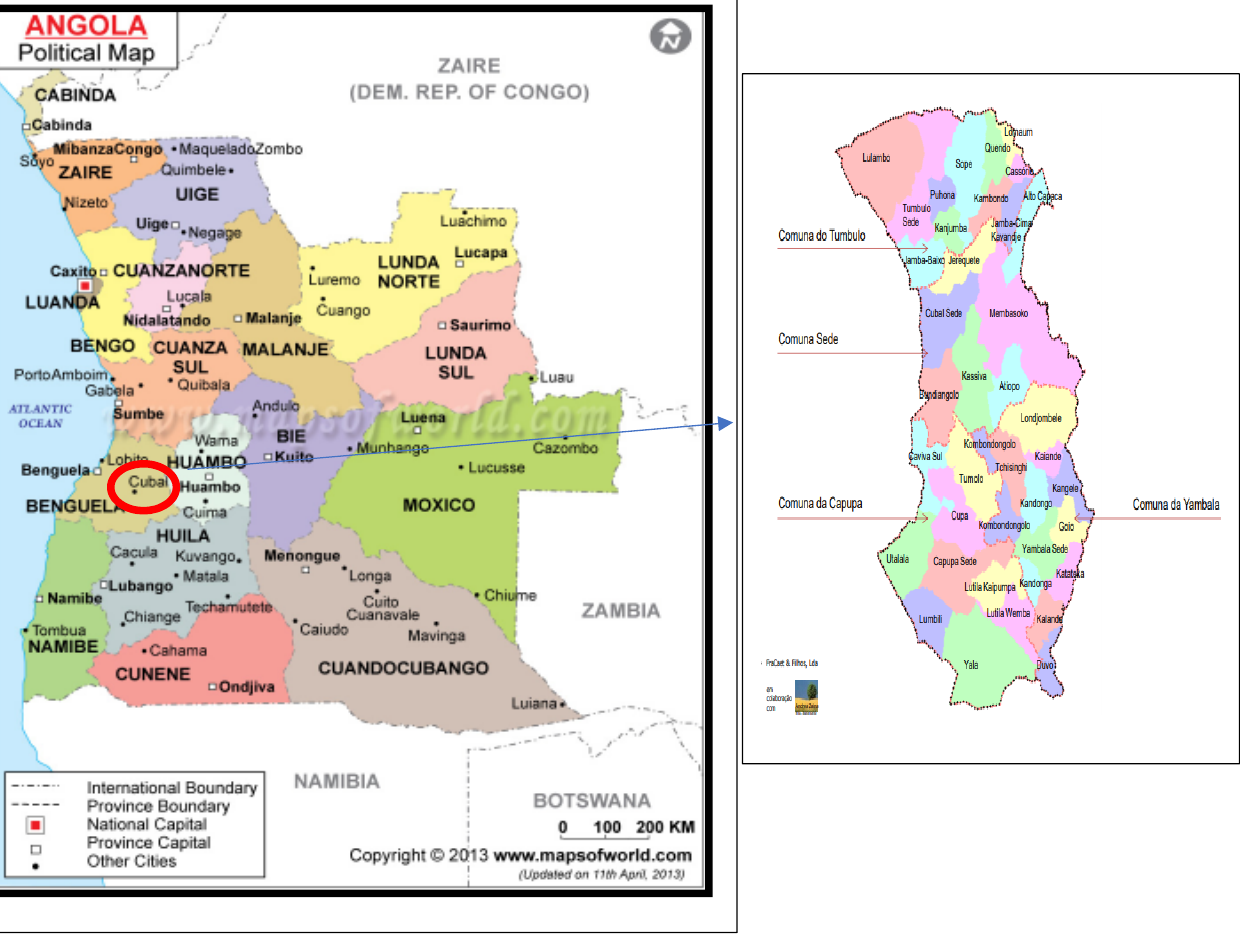
Figure 1. Map of Angola and map of